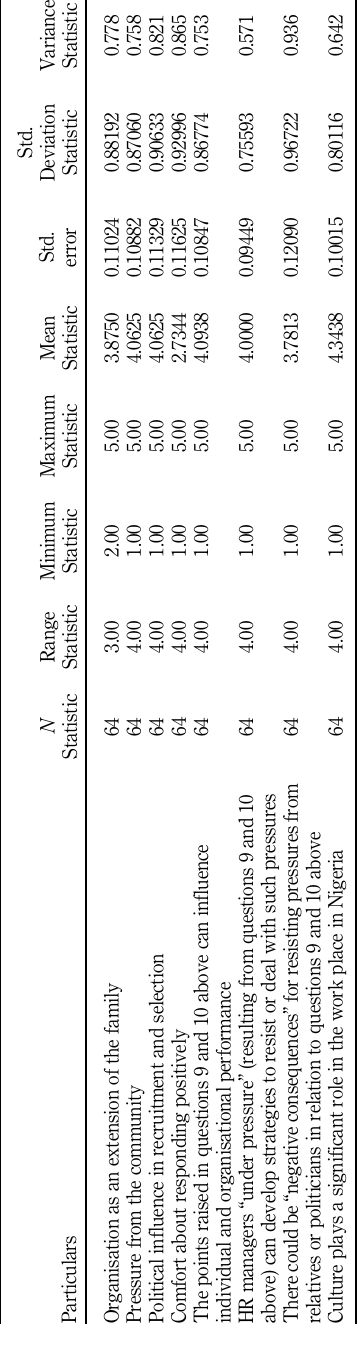
Table III. Descriptive